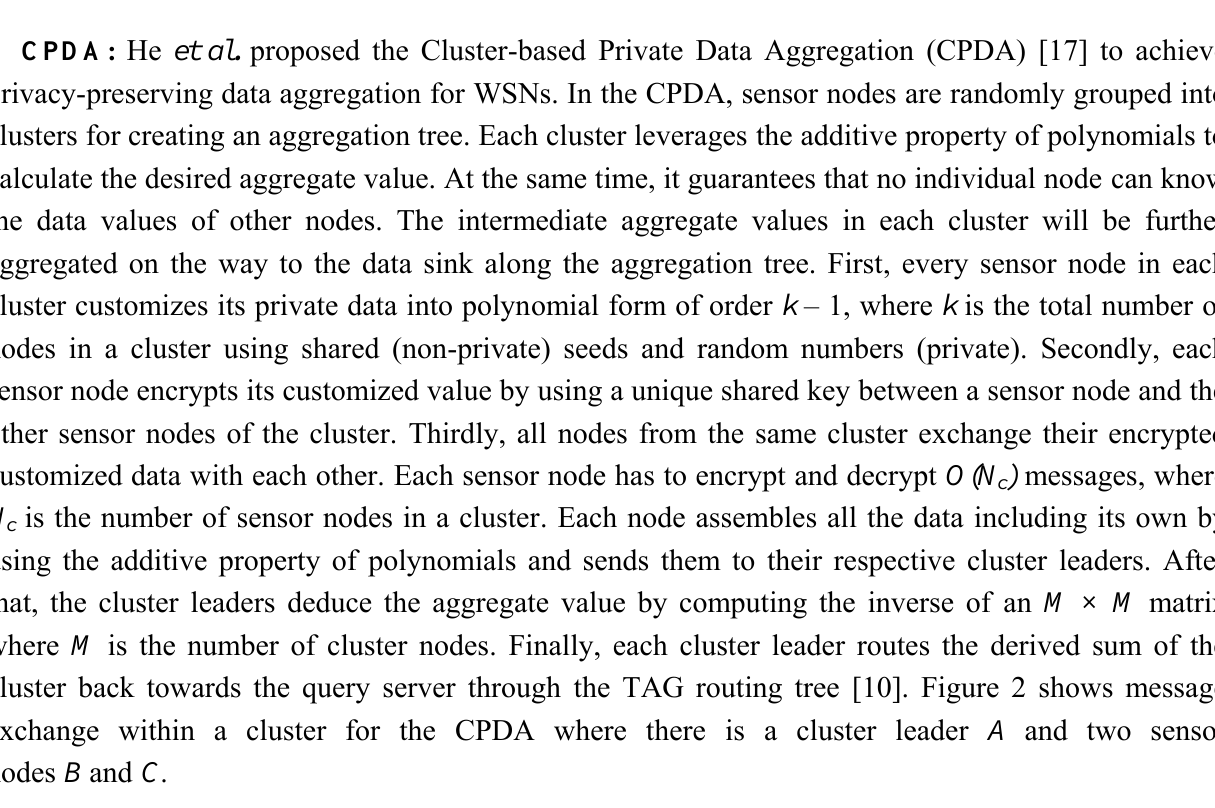
Figure 2. Message exchange within a cluster in the CPDA for (a) public seed broadcasting (b) customized data encryption & sending (c) assembled information